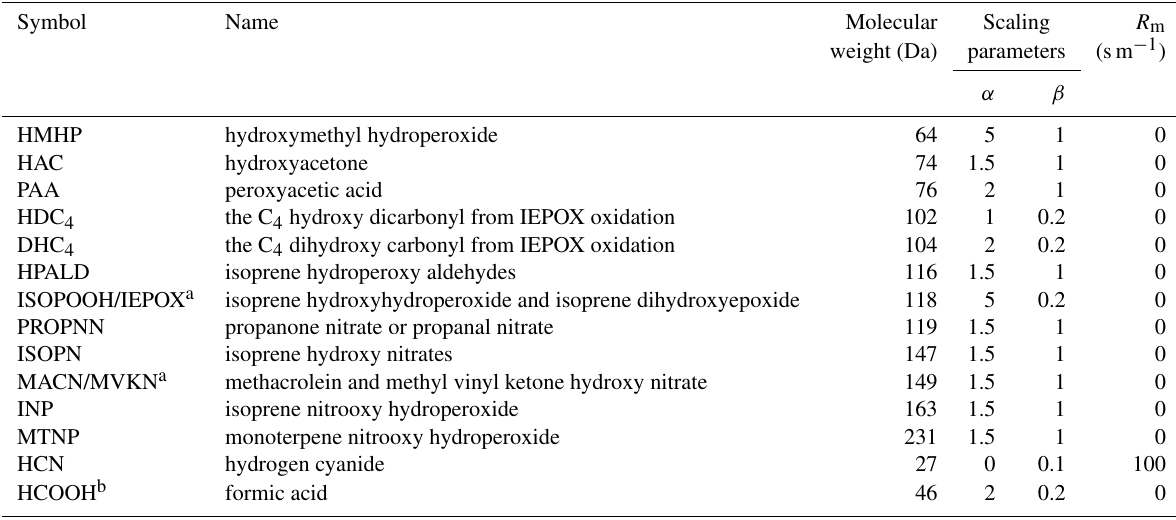
Table 1. List of model parameters needed in the scheme of Zhang et al. (2003) to simulate the dry deposition velocity of additional oVOC species and HCN: α and β are scaling parameters for non-stomatal resistance, and R m is mesophyll resistance. Symbol Name Molecular